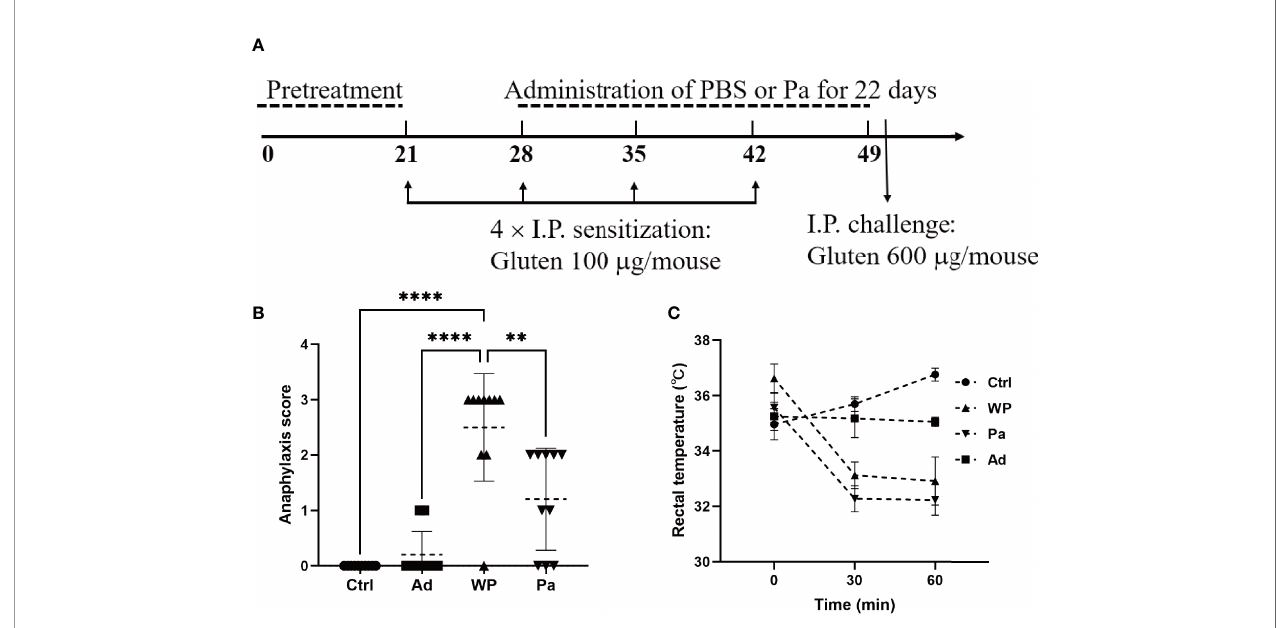
FIGURE 1 | (A) Experimental design of in vivo immunization. (B) Assessment of clinical symptom after the last challenge. (C) Assessment of rectal temperature. Ctrl, non-immunized negative control; WP, group injected with gluten and adjuvant; Pa, treated with Pediococcus acidilactici XZ31 ; Ad, group injected with adjuvant. Data are shown as the mean value ± standard error of the mean of 10 independent experiments. The asterisk indicates a statistically signi fi cant difference ( P <0.05).